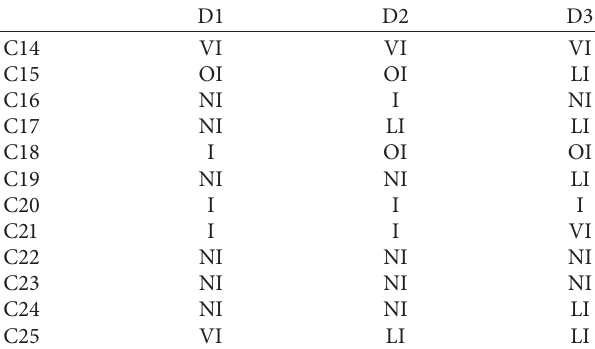
Table 6: Linguistic terms of experts’ viewpoint in environmental